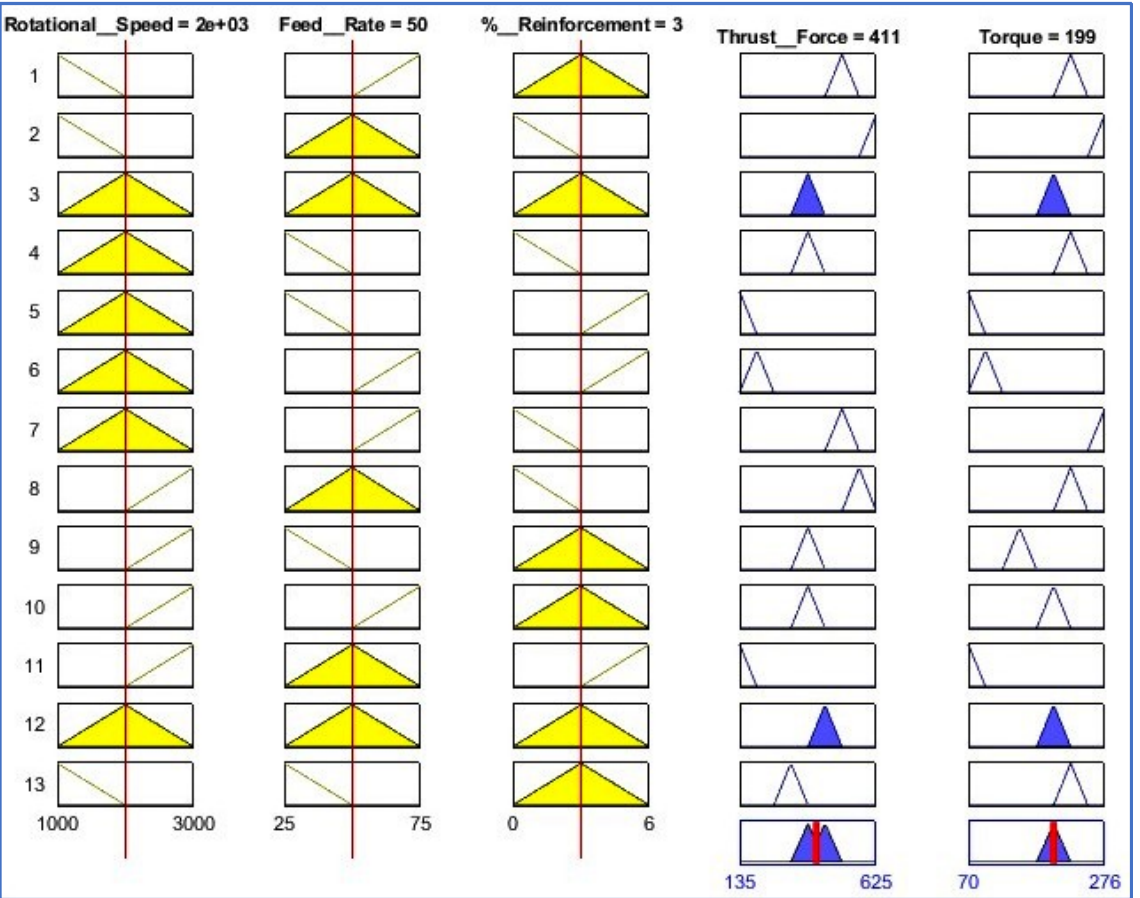
Figure 7. Rule editor representing the developed Fuzzy inference system.